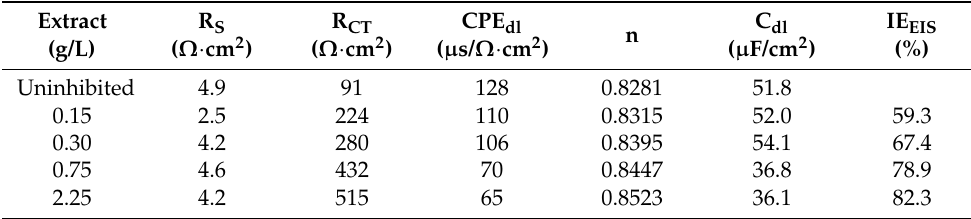
Figure 14. ( a ) Nyquist plots measured during the corrosion of MS specimens in 1 M HCl solution at 298 K containing different concentrations of tea tree extract; ( b ) equivalent circuit. Table 5. Electrochemical impedance parameters obtained from Figure 14a.